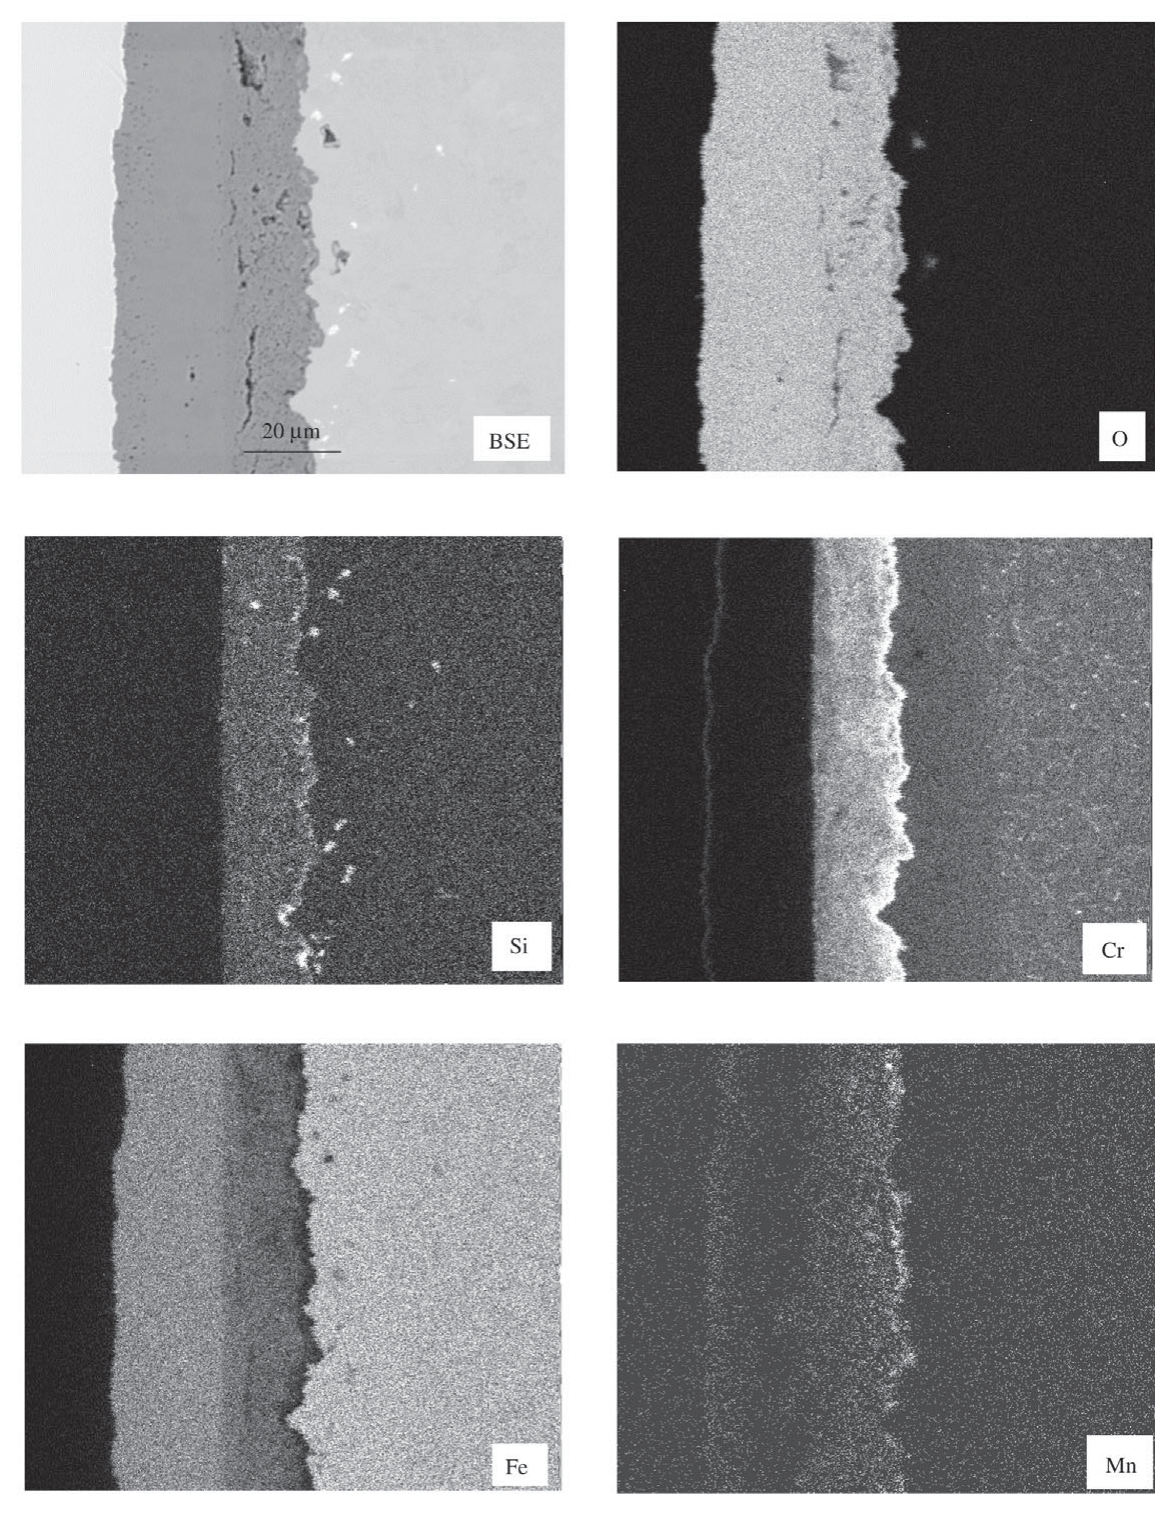
Figure 11. Elemental distribution maps for P91 at 650 °C in air with 4% H